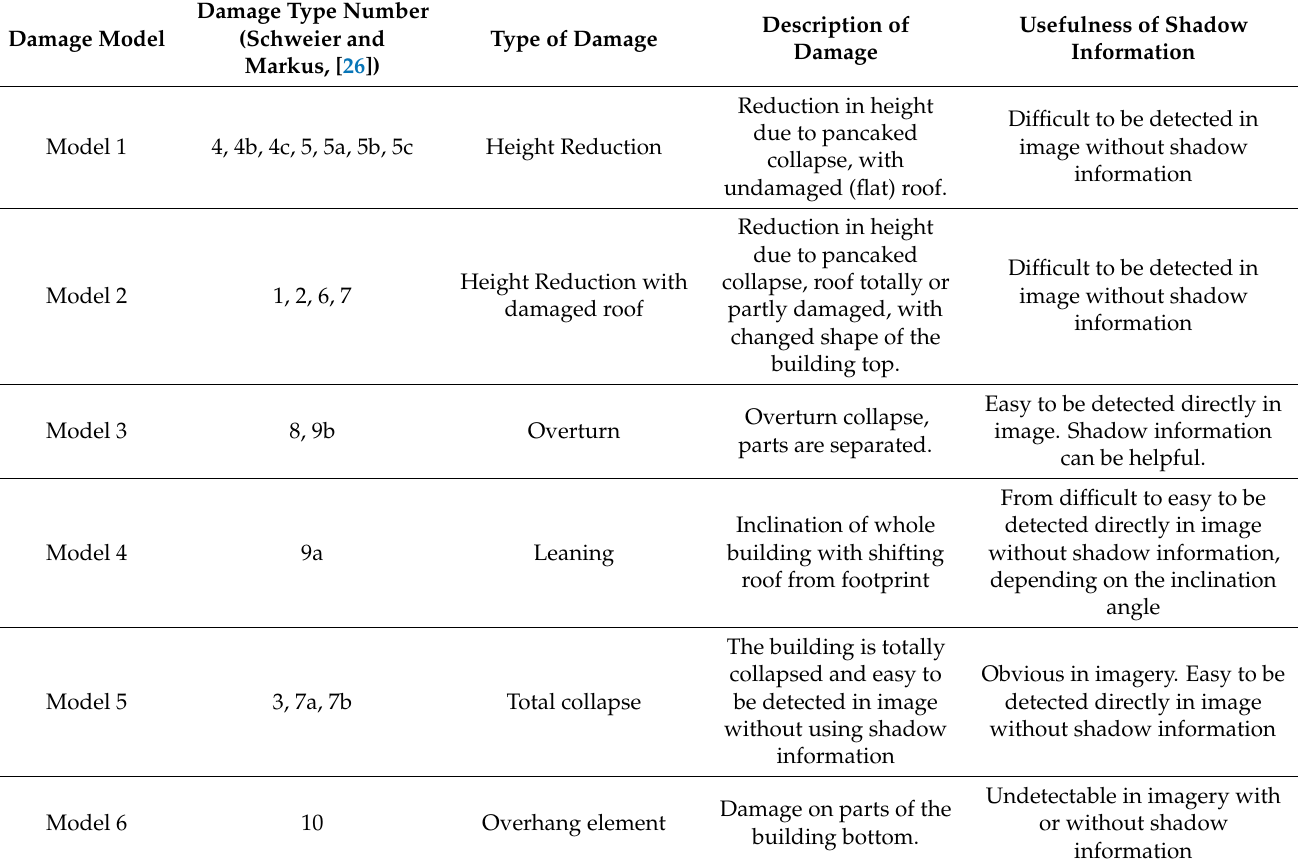
Table 1. Building damage type models and damage detectability in